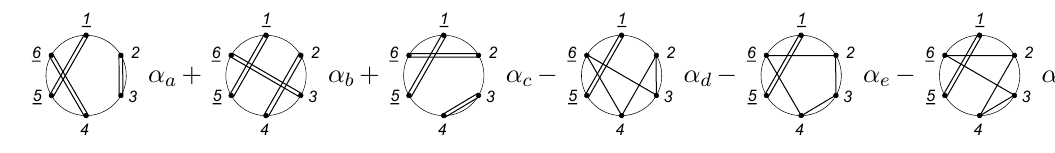
Figure 4 . All diagrams for A NLSM .